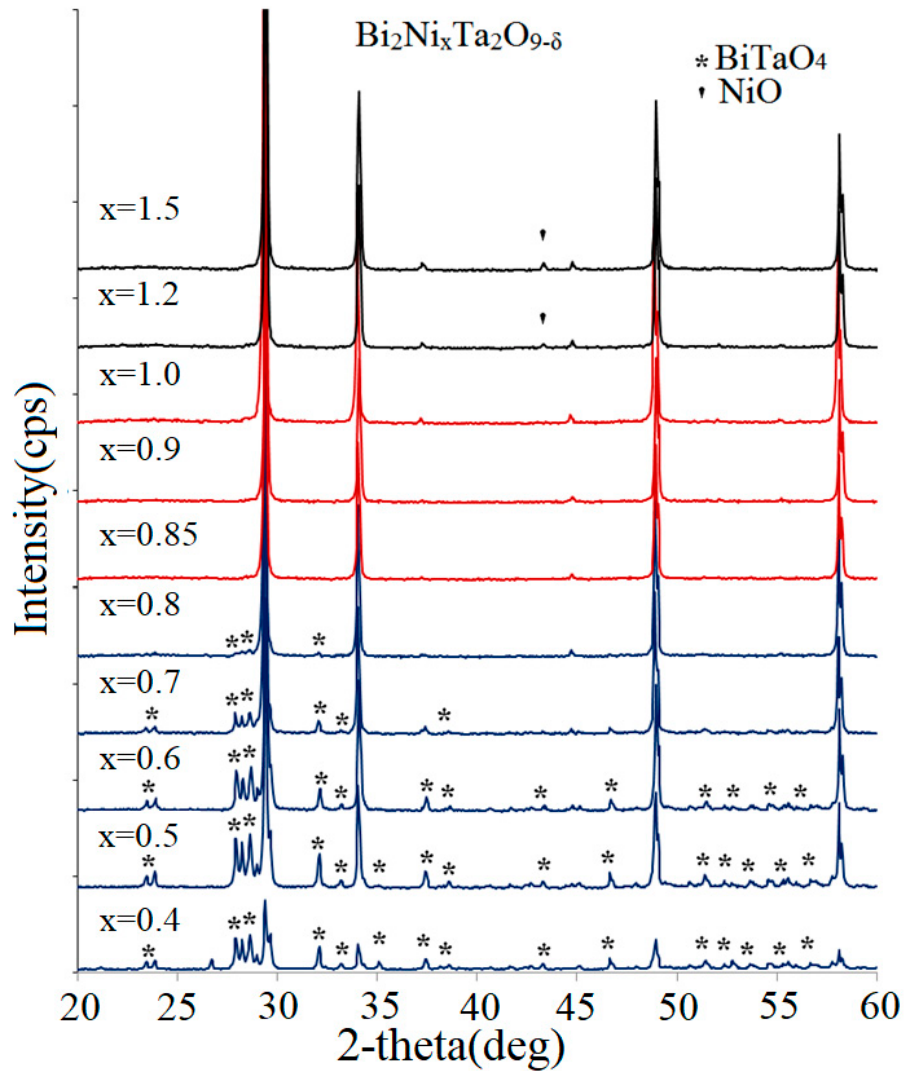
Figure 3. X-ray powder diffraction patterns of Bi 2 Ni x Ta 2 O 9- δ (0.4 ≤ x ≤ 1.2) samples.